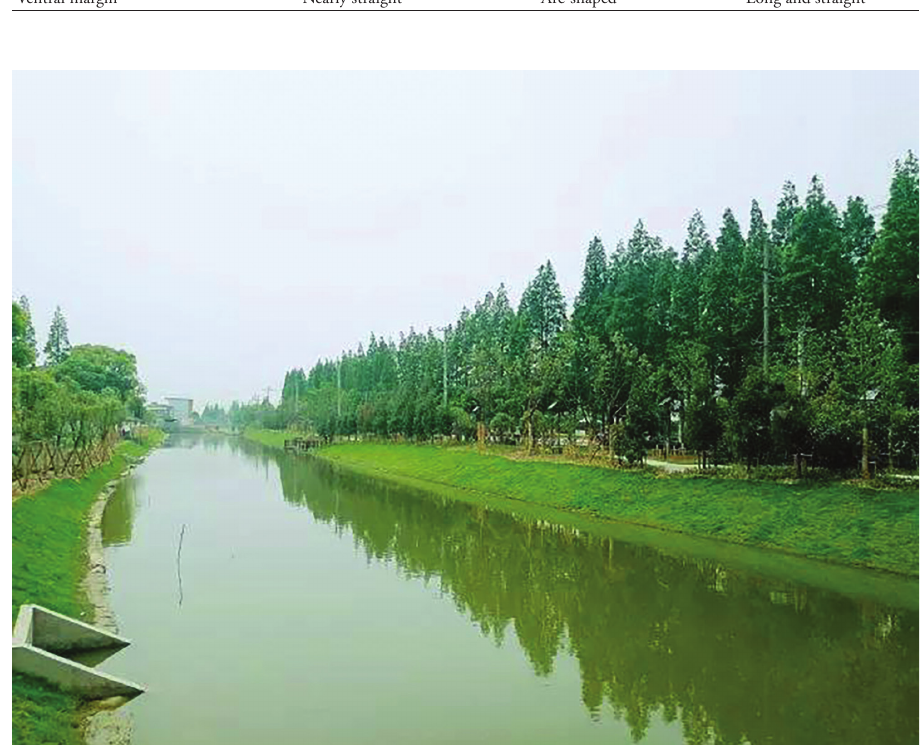
Figure 2. Photograph of sampling site of Inversidens rentianensis sp. nov. in China.